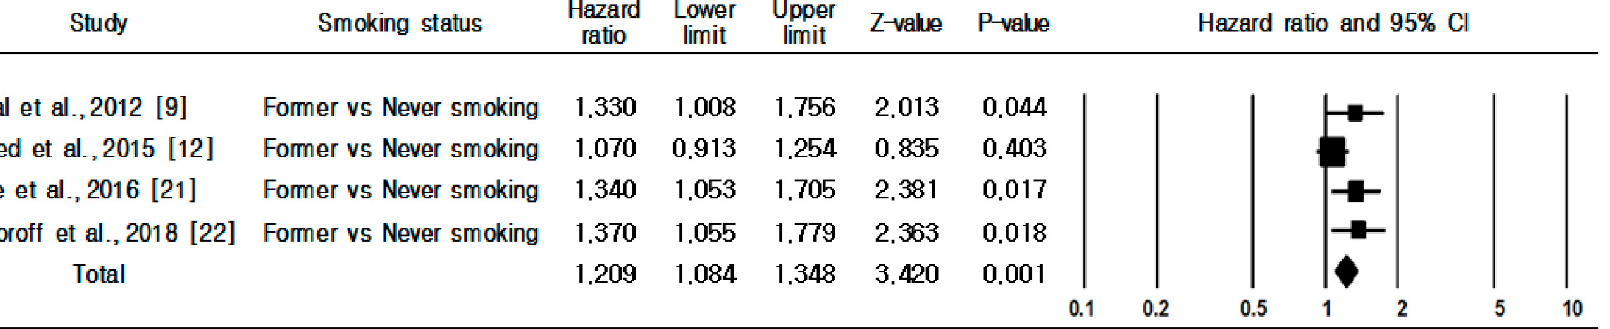
Figure 3. Heart failure incidence in former smokers versus never smokers.